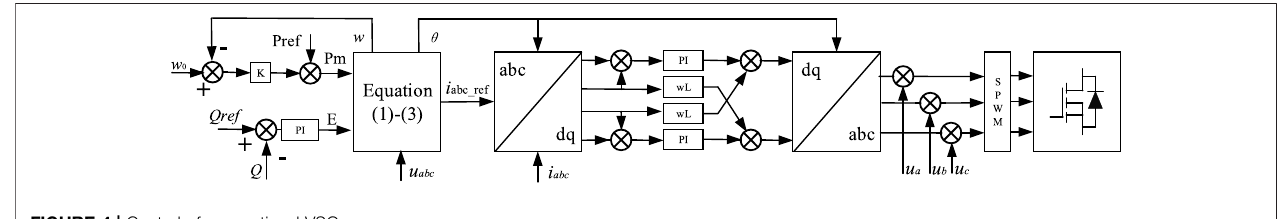
FIGURE 4 | Control of conventional